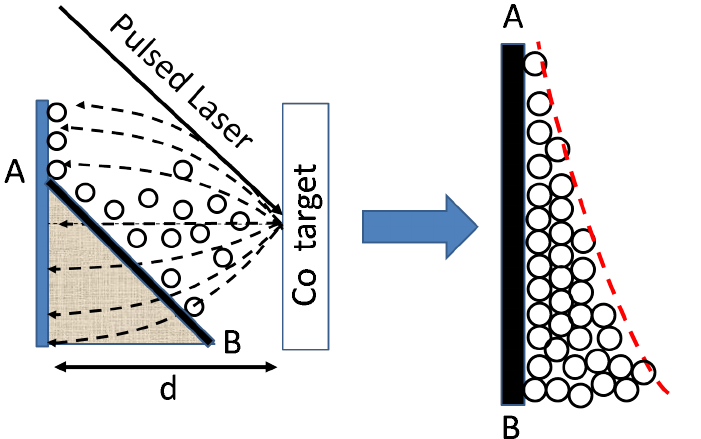
Figure 1. Sketch showing the deposition of a characteristic nanocluster 2D assembly under growing parameters indicated in the text. In this off-axis geometry, the glass substrate corresponds to the solid line AB. On the right, we show a simulated thickness profile of the grown Co